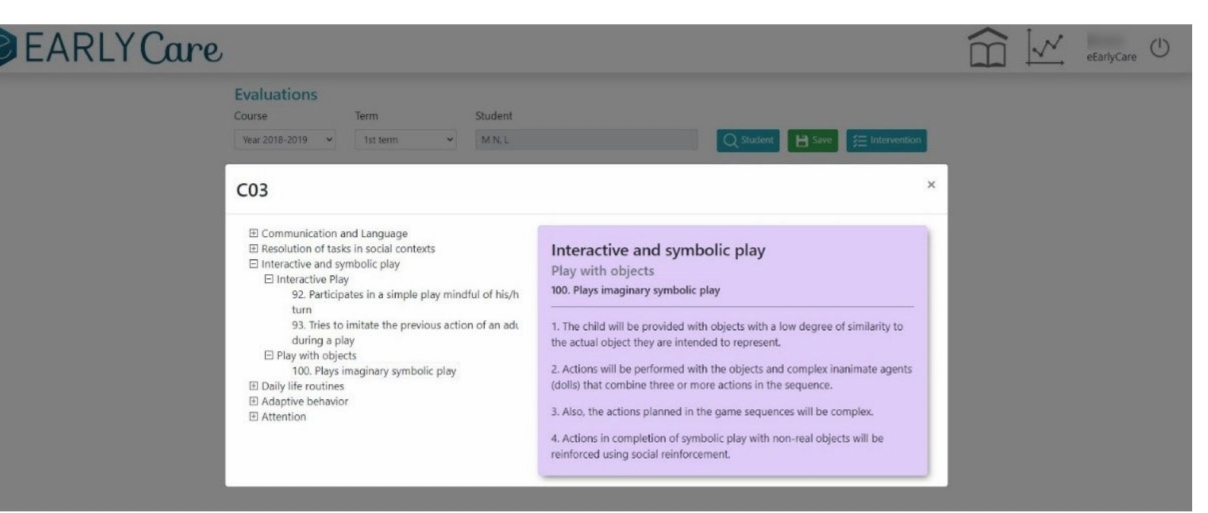
Figure 7. Example of a proposal for a personalized therapeutic intervention in the area interactive and symbolic play with